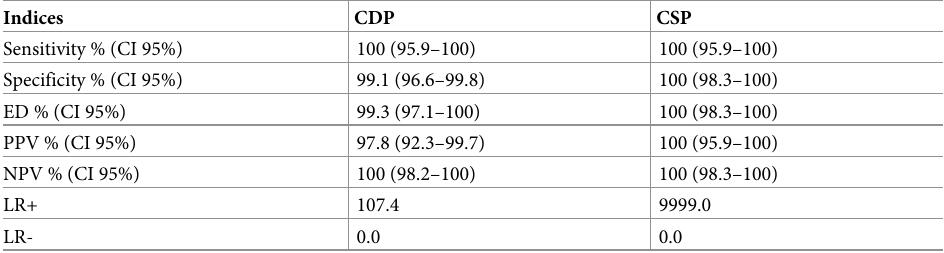
Table 4. Indices of validity and security for RDT’s for the diagnosis of